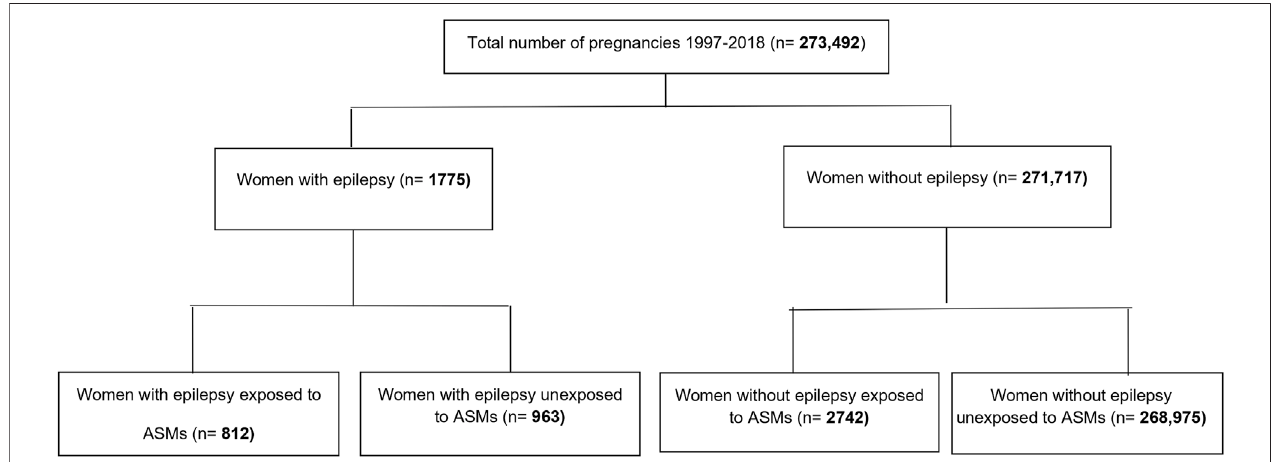
FIGURE 1 | Study fl